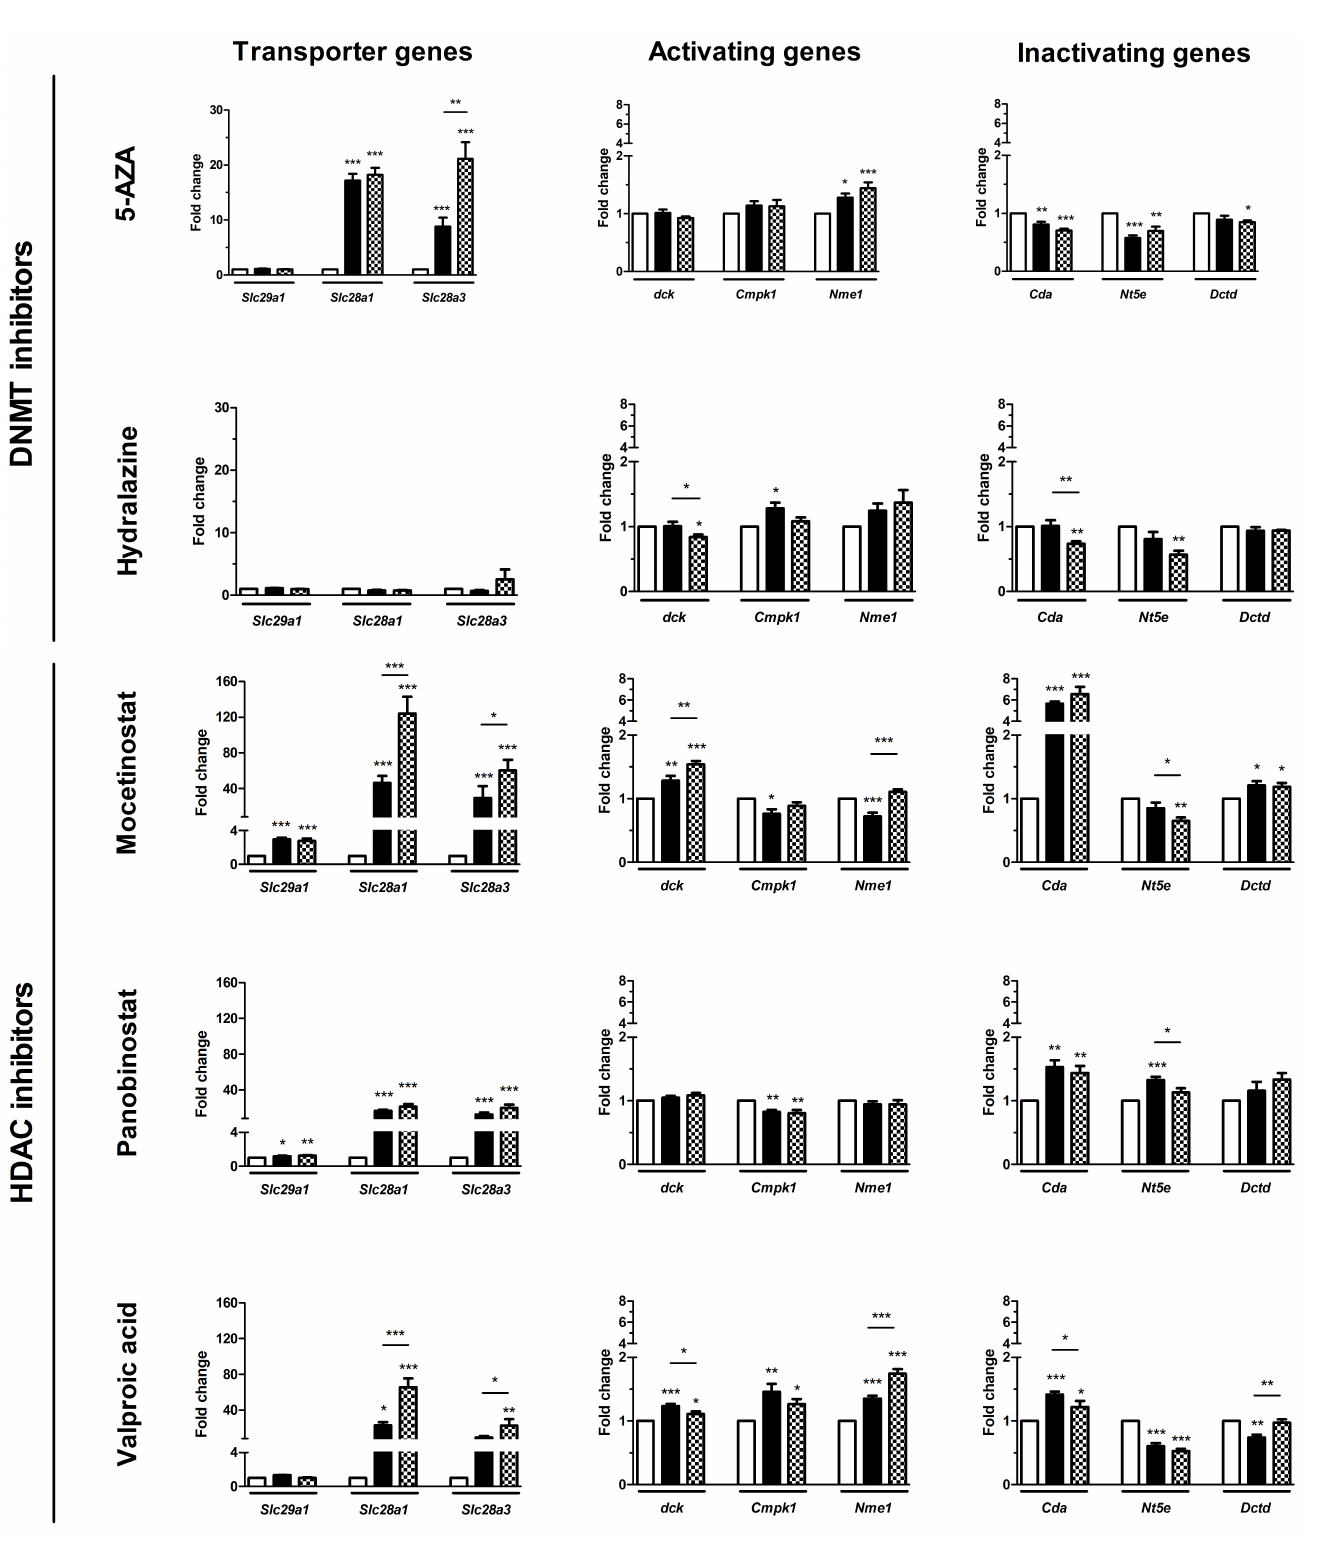
Figure 4. Effect of epi-drugs on mRNA expression of genes involved in gemcitabine metabolism. Fold change in mRNA expression between untreated control cells (white bar) and after seven days IC 25 epi-drug treatment (black bar) or IC 50 epi-drug treatment (dotted black bar). Values represent mean ± SEM of at least two independent experiments in quadruplicate and are shown relative to control (set as 1). * p < 0.05, ** p < 0.01, and *** p < 0.001 versus